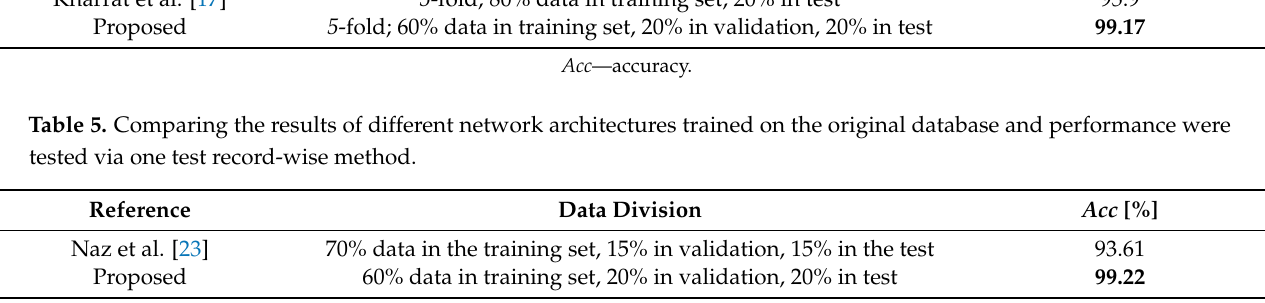
Table 4. Comparing the results of different network architectures trained on the original database and performance were tested via k -fold cross-validation record-wise method. Reference